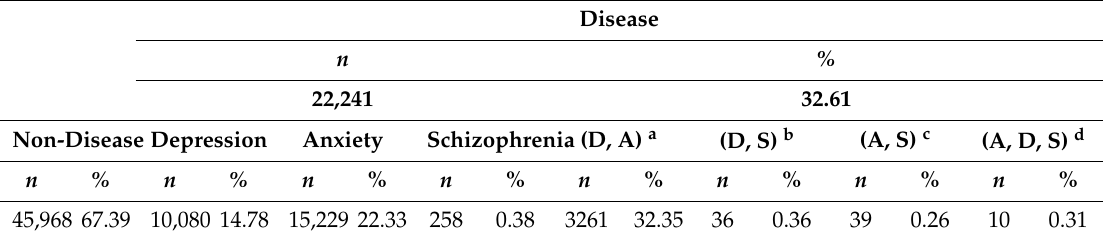
Table 2. Summary of non-disease patients and patients with mental illness ( n =